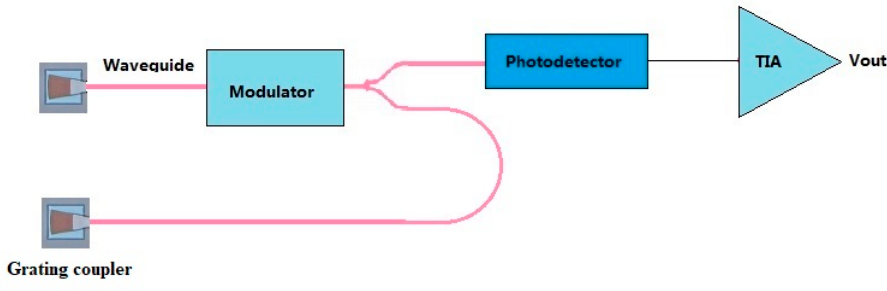
Figure 5. Block diagram of a complementary metal oxide semiconductor (CMOS) photonic circuit.